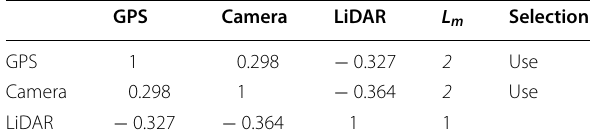
Table 2 Correlation table at 152 s in Fig.